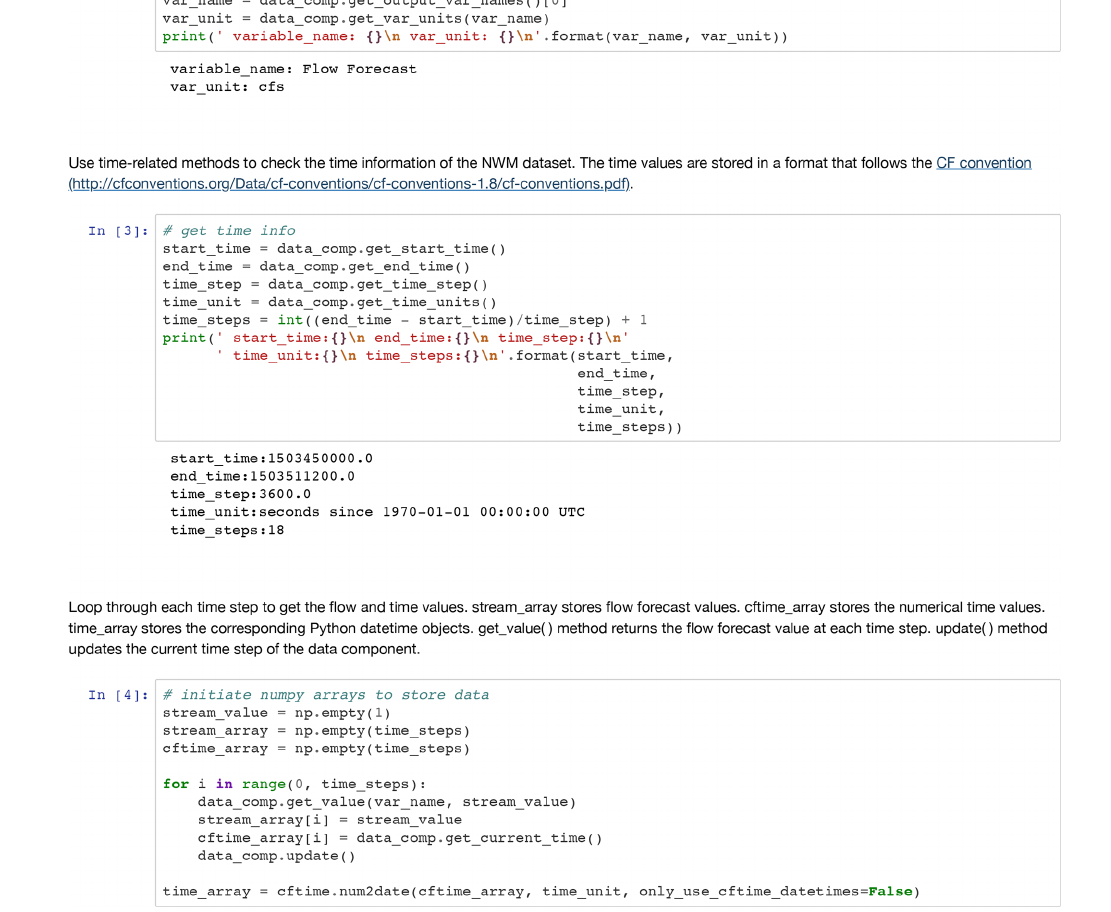
Figure 8. Screenshot of a Jupyter Notebook demonstrating how to use the NWM data component to access and subset a streamflow